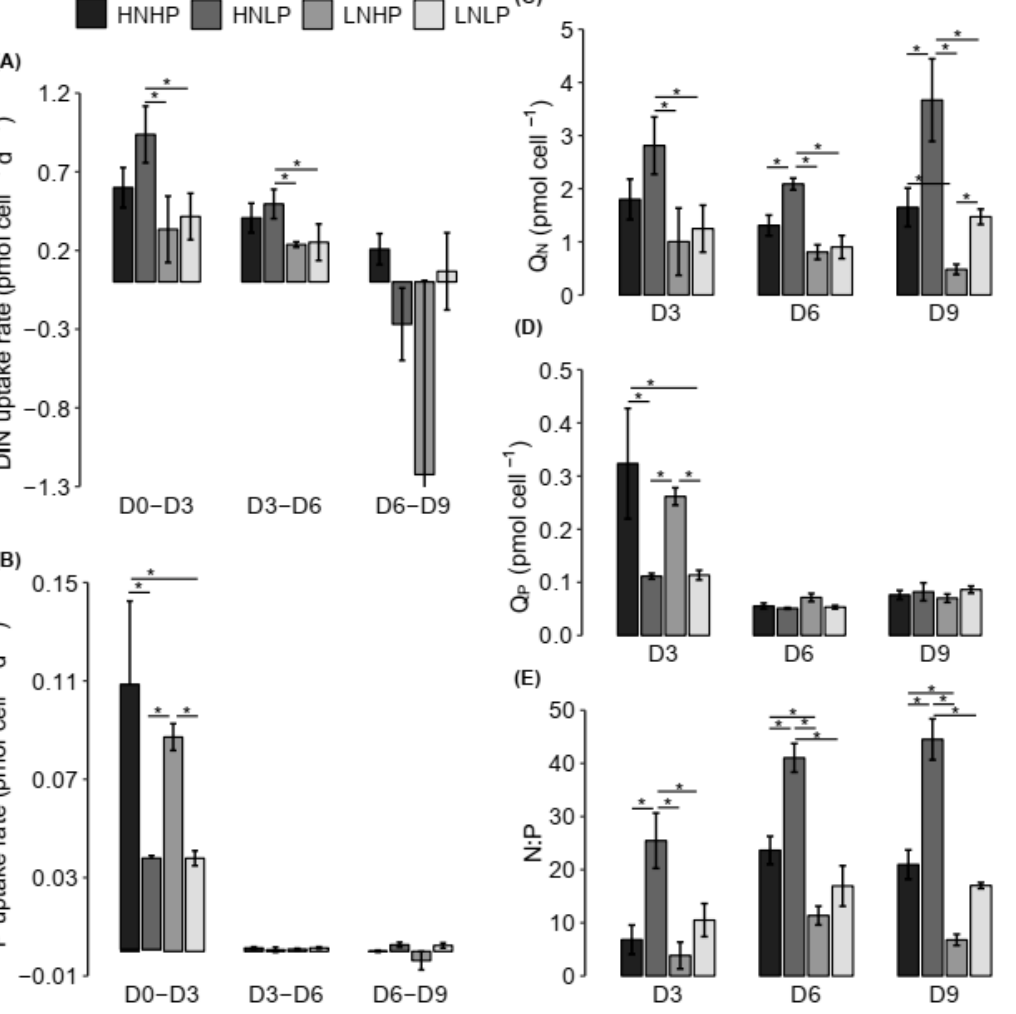
Figure 3. Nutrient uptake rate (pmol cell − 1 d − 1 ) and conversion in the cultures during different time intervals in the four nutrients scenarios. ( A ) DIN uptake/release rate; ( B ) Phosphate uptake/release rate; ( C ) Nitrogen quota; ( D ) Phosphorus quota; ( E ) Cellular N:P. The error bar represents the standard error (number of samples = 3). * p < 0.05.